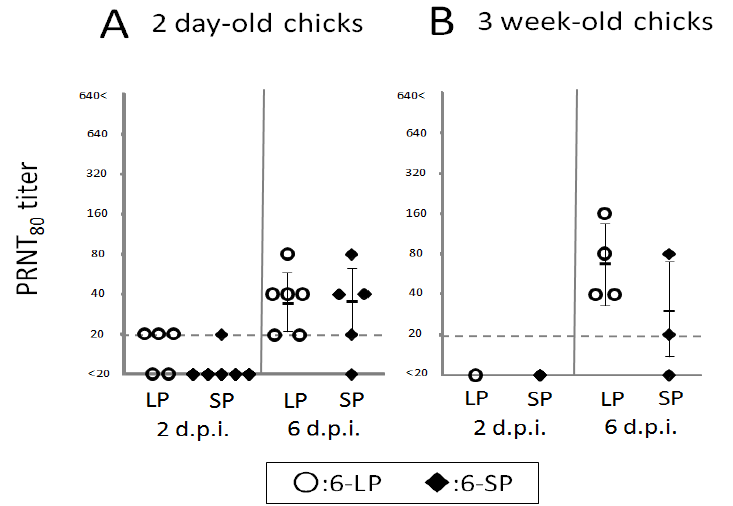
Figure 6. Primary neutralizing antibody responses in chicks inoculated with WNV 6-LP or 6-SP. Two-day-old ( A ) and 3-week-old ( B ) chicks (n = 3–6) were inoculated with 10 2 PFU of WNV 6-LP ( ○ ) or 6-SP ( ◆ ). WNV neutralizing antibody titers were then measured by PRNT . Individual and mean PRNT titers are represented by symbols and 80 80 bars, respectively. When mean values were calculated, the titers of samples under the detection limit were considered to be 20.